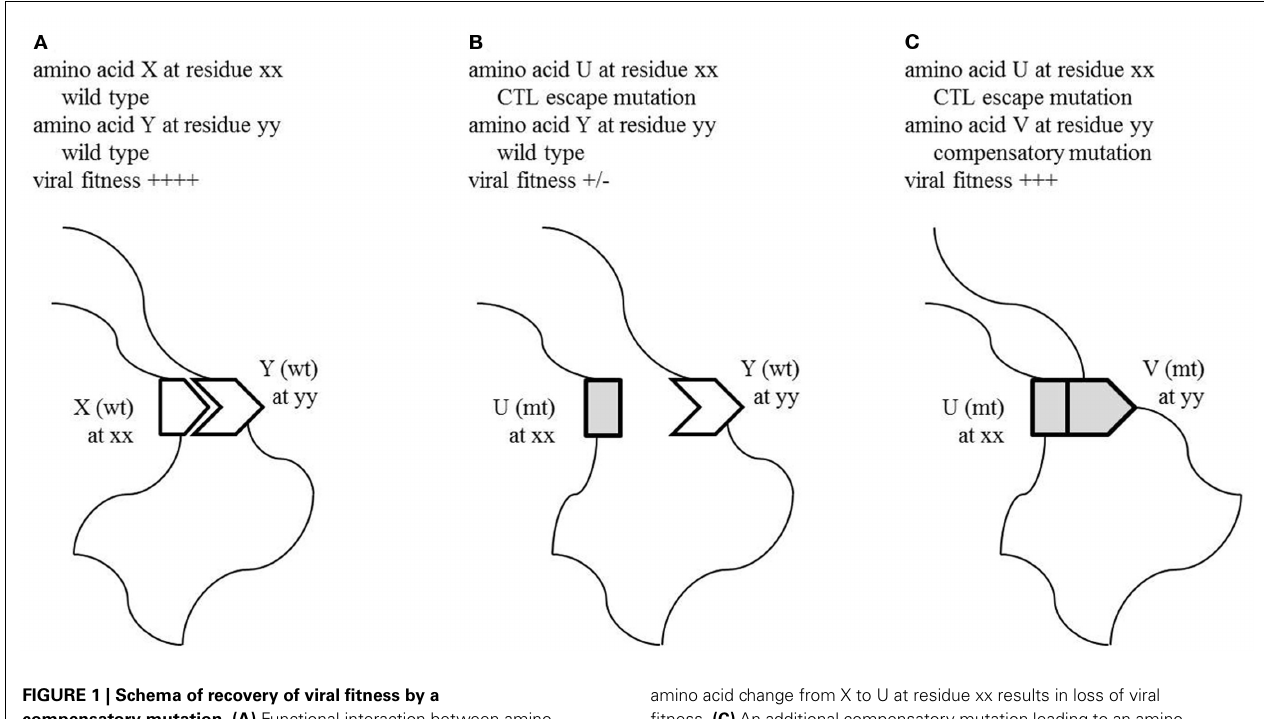
FIGURE 1 | Schema of recovery of viral fitness by a compensatory mutation. (A) Functional interaction between amino acid X at residue xx andY at residue yy in wild-type viral protein is critical for viral replication. (B) A CTL escape mutation leading to an